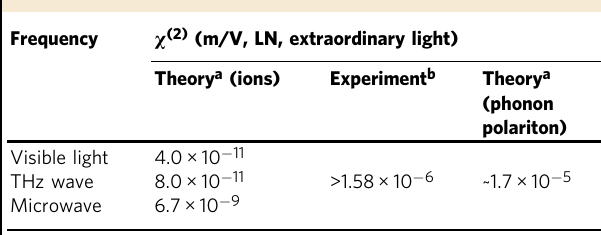
Table 1 Comparison between experimentally obtained second-order nonlinear susceptibility and theoretically calculated values, along with prior results obtained at other frequency 36 .